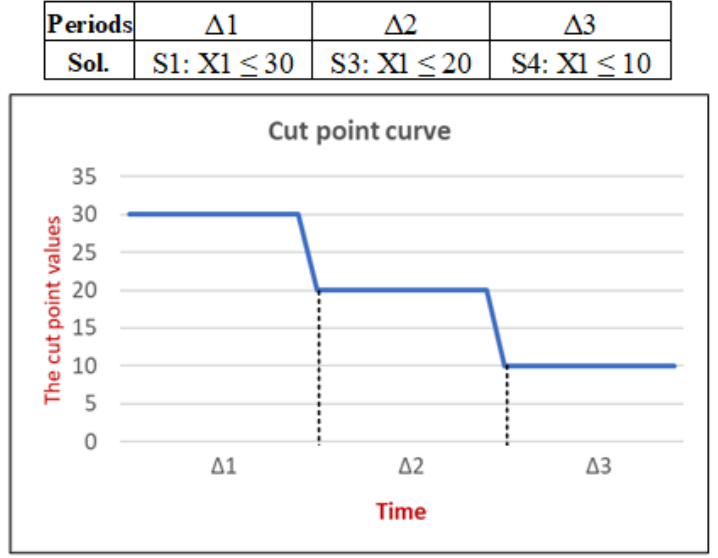
Figure 4. Curve of the cut-point values of similar feasible solutions obtained over time.